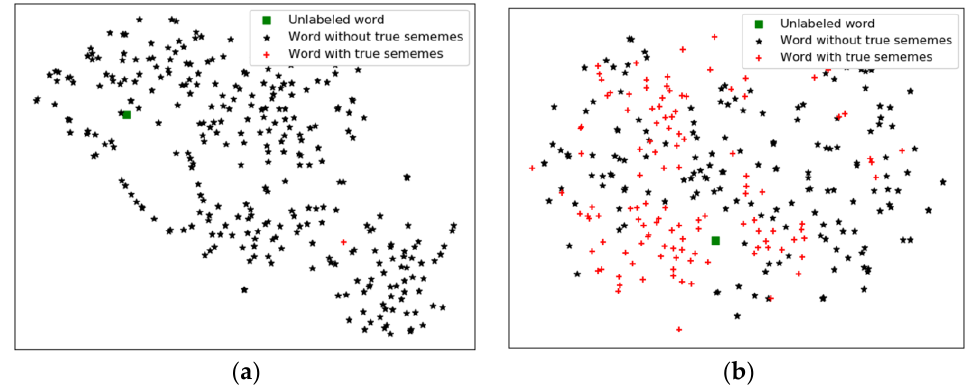
Figure 4. Top 300 similar words of the unlabeled word ( a ) “ 申雪 ” ( b ) “ 便士 ” in the word vector space, where “+” means that the sememes can be recommended for the unlabeled word because the word contains the true sememe of the unlabeled word; “*” presents a word that it is impossible to recommend the true sememe for unlabeled word because the word and the unmarked word do not contain the same sememes.